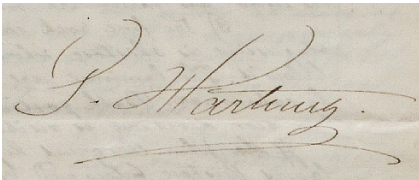
Figure 2. The signature of Georg Hartung found, in a partial letter addressed to Lyell, within Lyell’s manuscript dealing with Madeira (see Lyell, 1854/1855). Image courtesy of the University of Edin- burgh Library, under Creative Commons – attribution CCBY 4.0